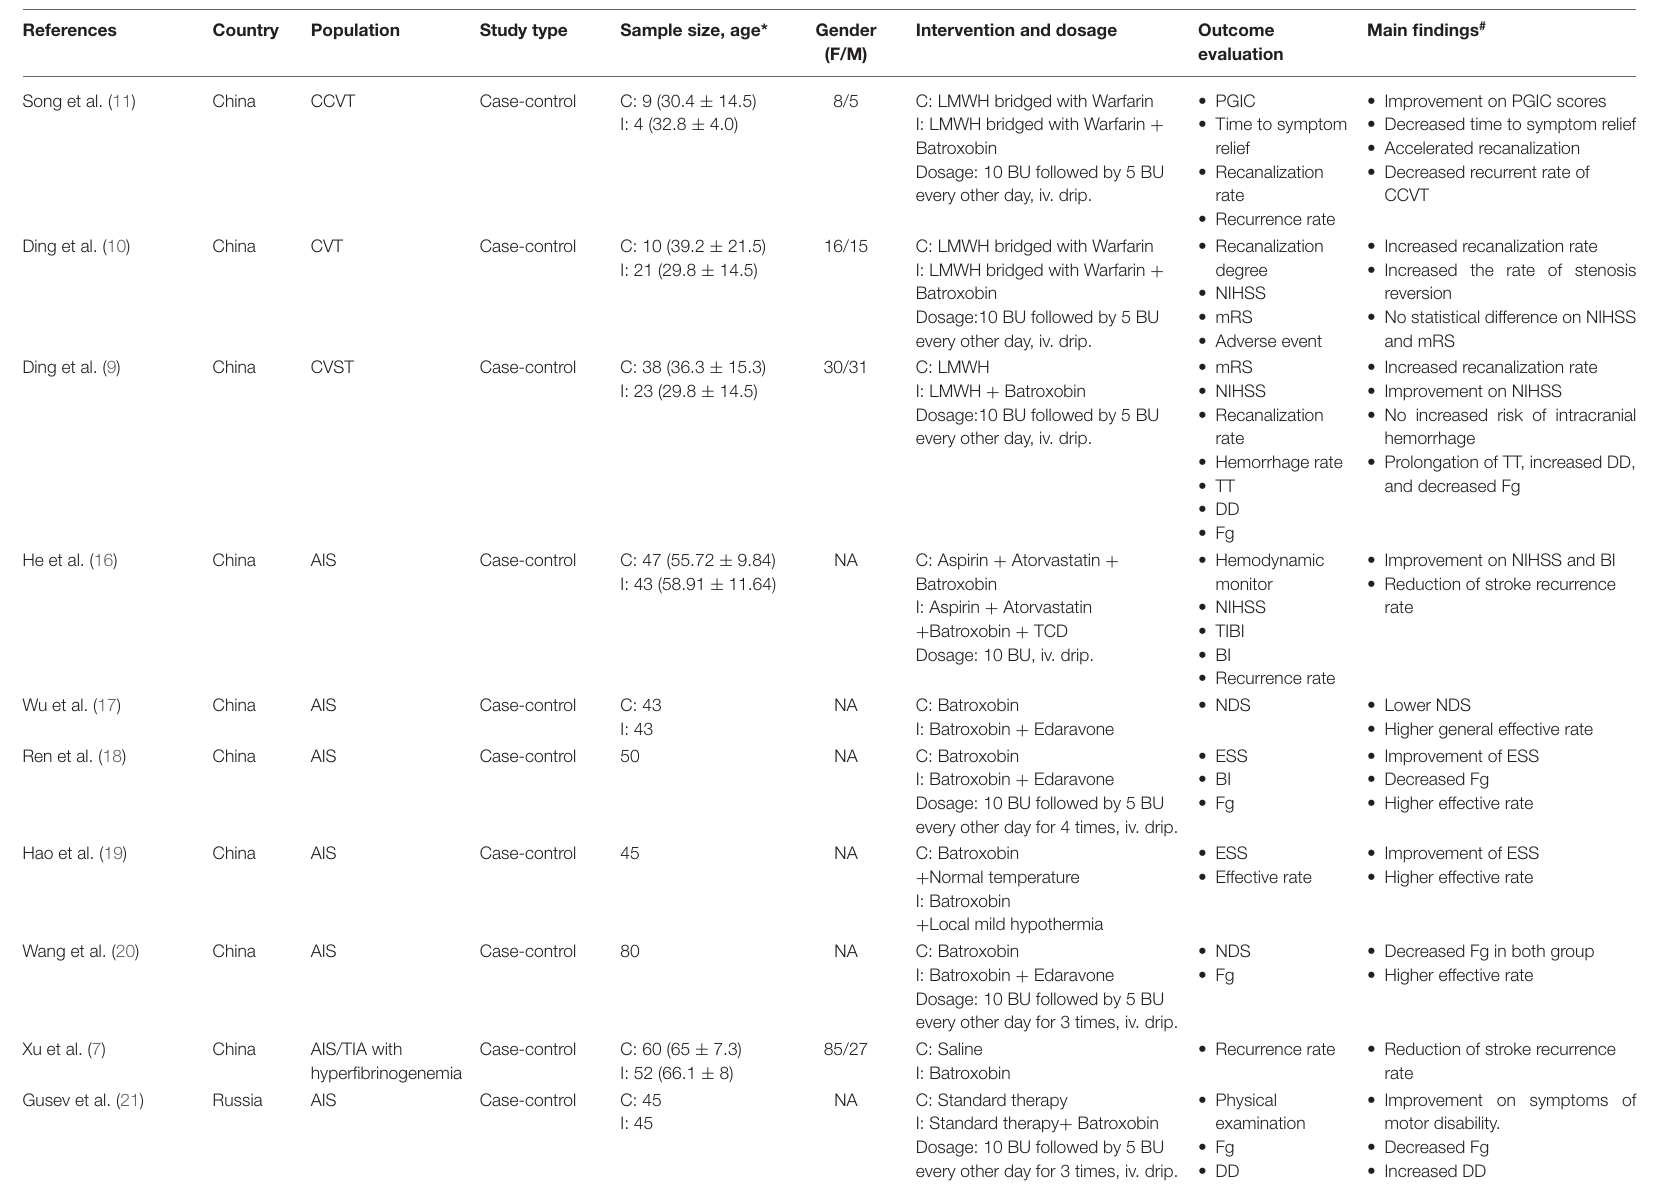
TABLE 1 | Application of Batroxobin in clinical